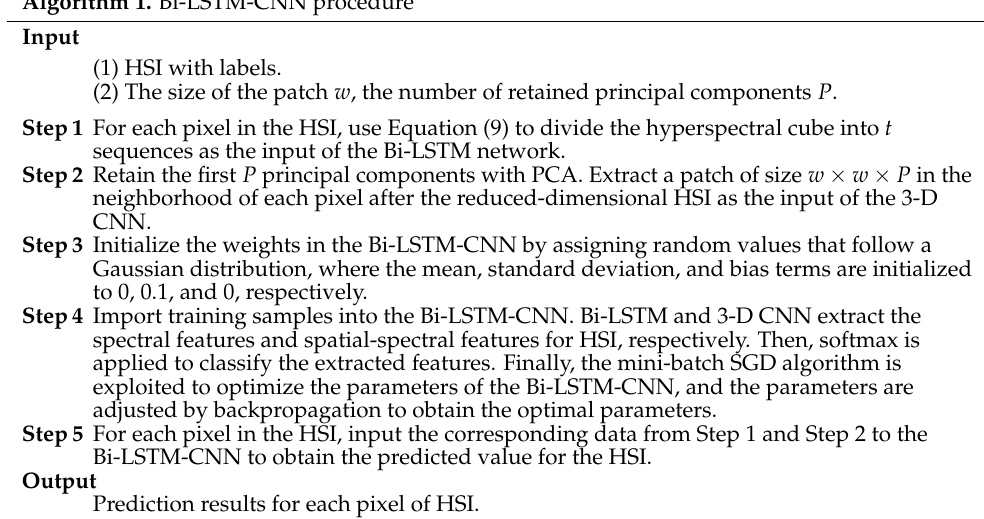
Algorithm 1. Bi-LSTM-CNN